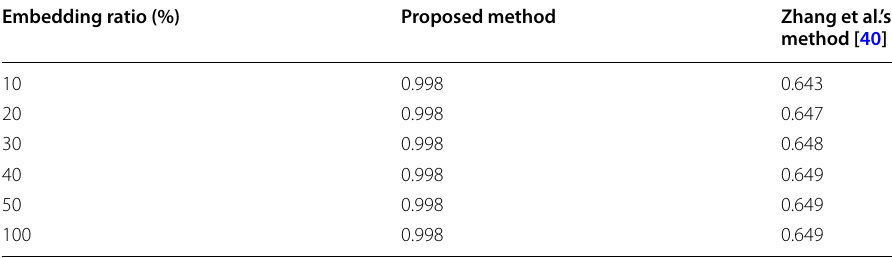
Table 10 Comparison of the precision for the UCID database images Embedding ratio